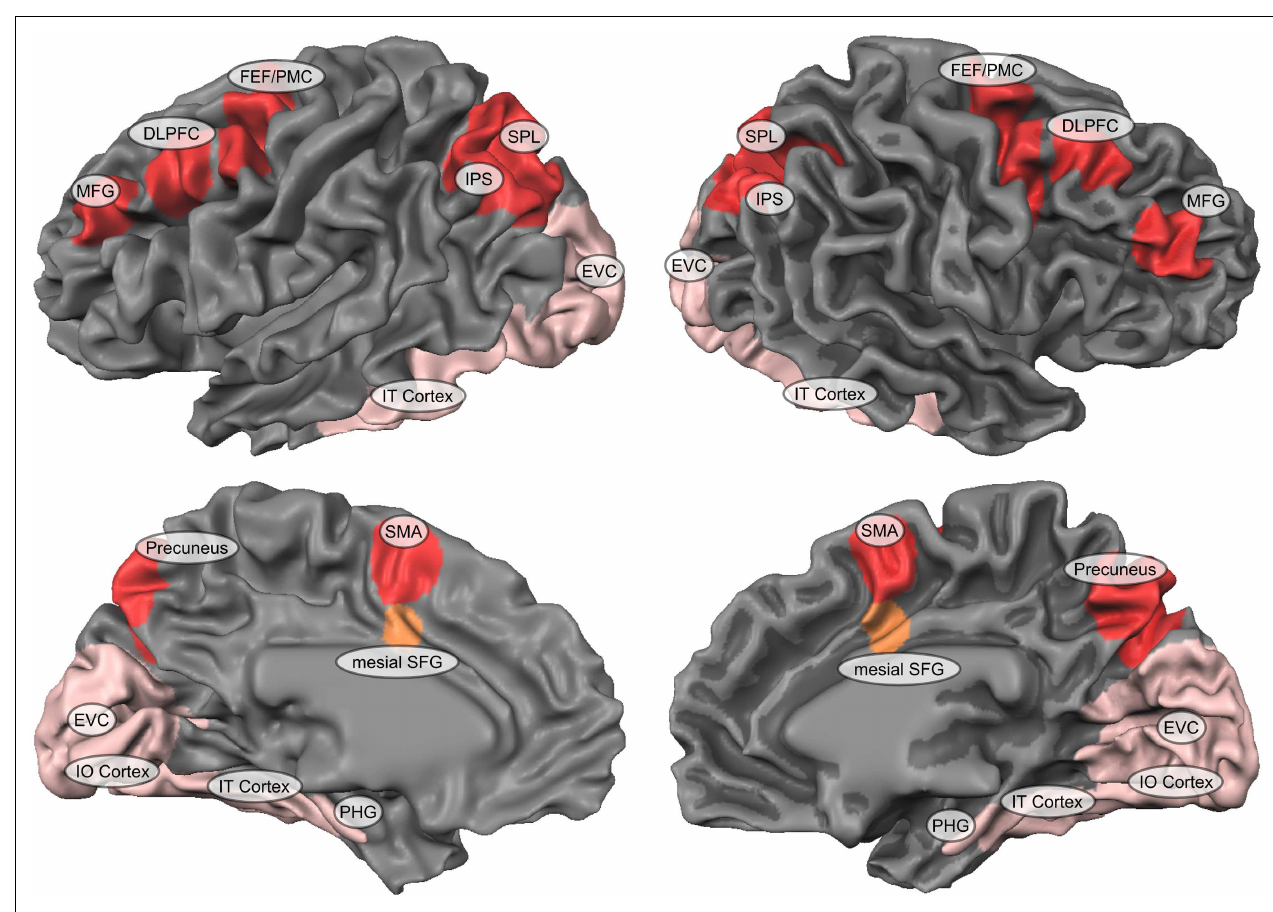
lobe; IPS, Intraparietal sulcus; MFG, middle forntal gyrus; DLPFC, dorsolateral prefrontal cortex; FEF, frontal eye fields; PMC, premotor cortex; Precuneus; and SMA, supplementary motor area. Most prominent regions within the ventral occipito-temporal network include bilateral EVC, early visual cortex; IT, inferior temporal cortex; IO, inferior occipital cortex; PHG, parahippocampal gyrus.The mesial superior frontal gyrus (mSFG) plays a special integrative role in the context of spatial imagery and is therefore color-coded